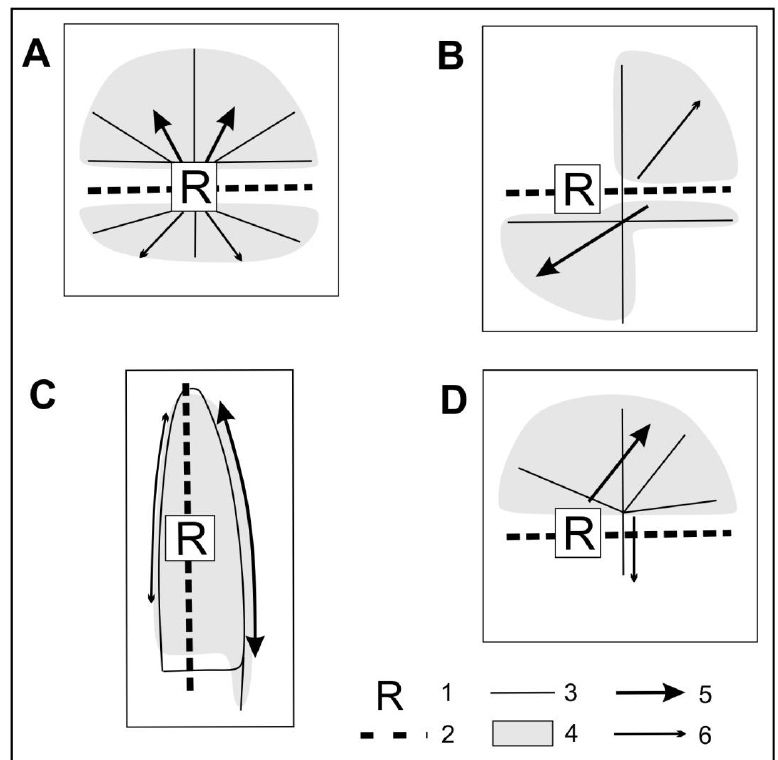
Fig. 8. Urban layout model of railway settlements and direction of their development: A – Łapy, B – Korsze ( Korschen ), C – Prostki ( Prostken ), D – Iłowo-Osada ( Illowo ) (Source: author’s own study) 1 – railway station with its buildings, 2 – railway line, 3 – street layout, 4 – built-up area, urban development intensity: 5 – strong, 6 –